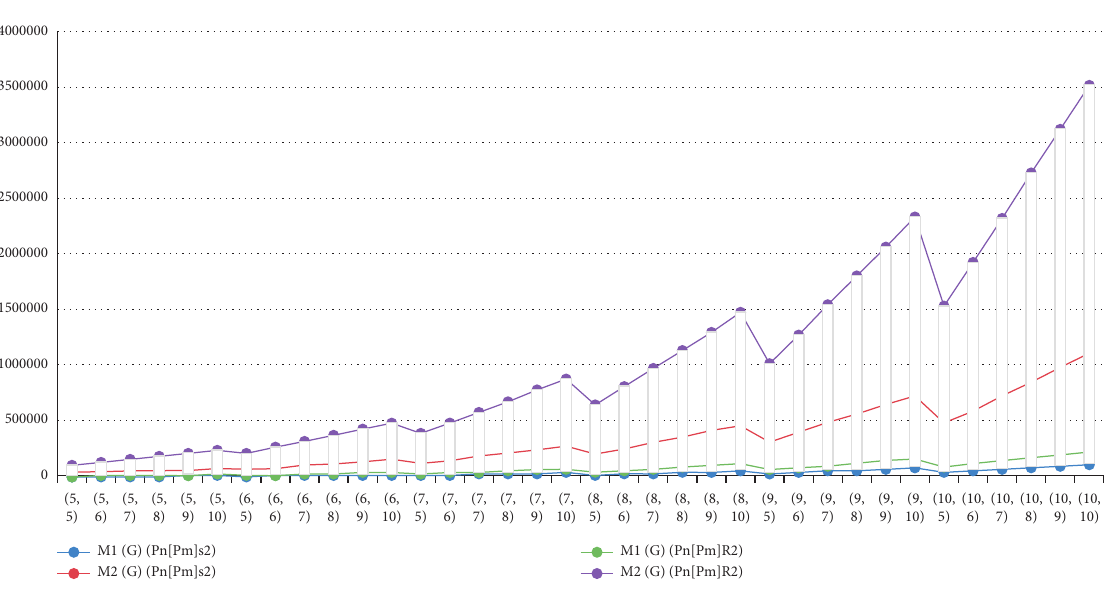
Figure 6: Numerical comparison of Zagreb indices of generalized subdivision and semitotal point operations with lexicographic product of the networks for k � 2.